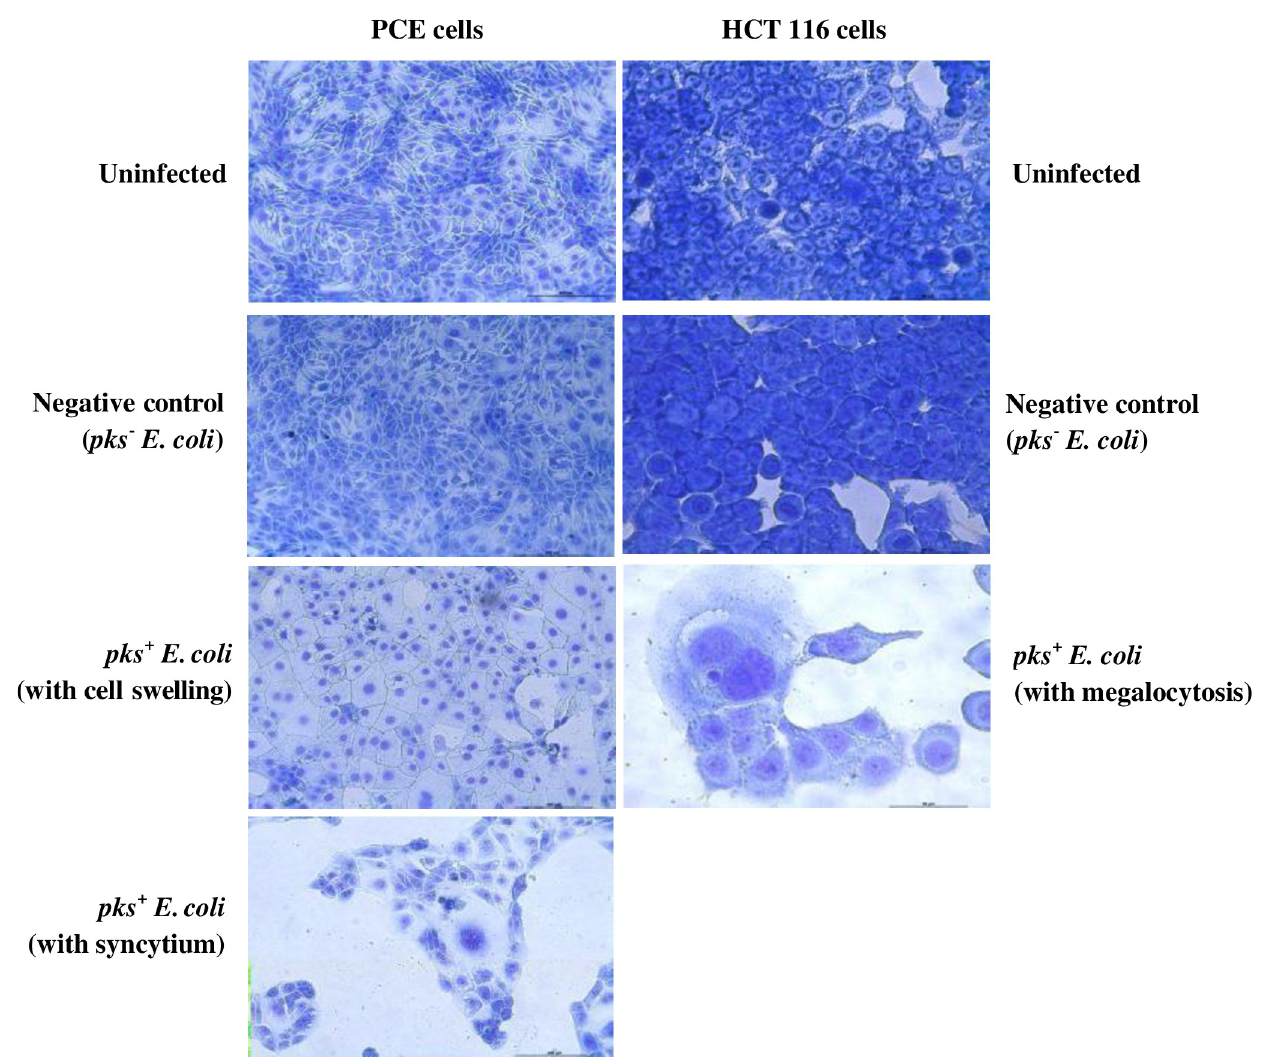
Fig 4. Cytopathic effect induced by pks + E . coli for both PCE and HCT116 cell lines.